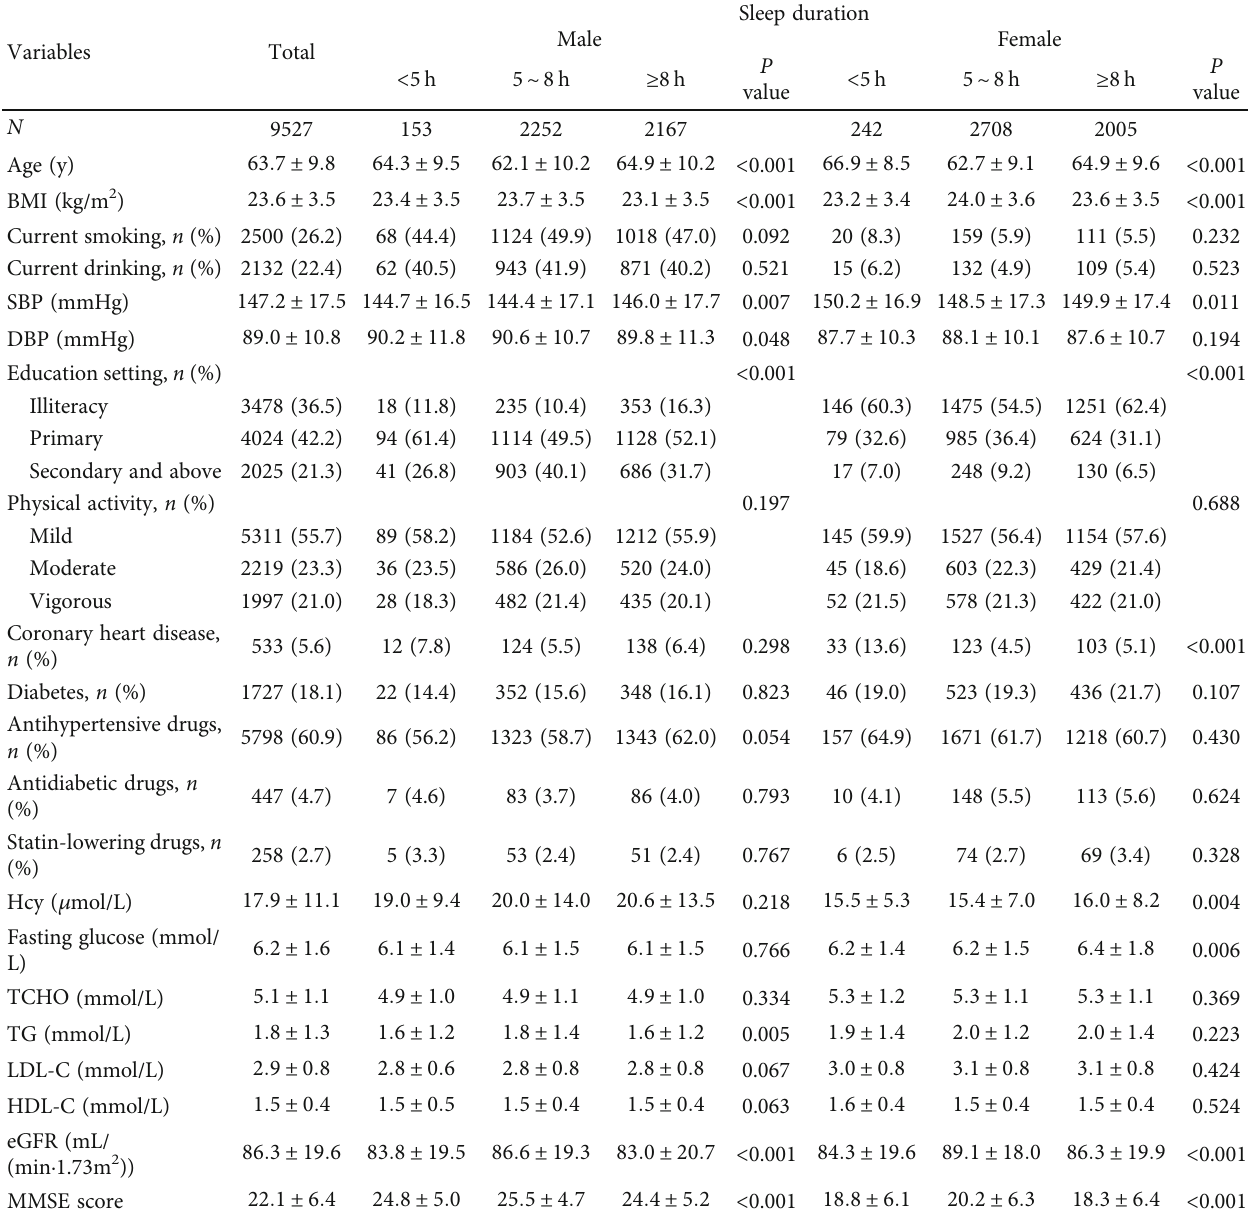
Table 1: Baseline characteristics of study